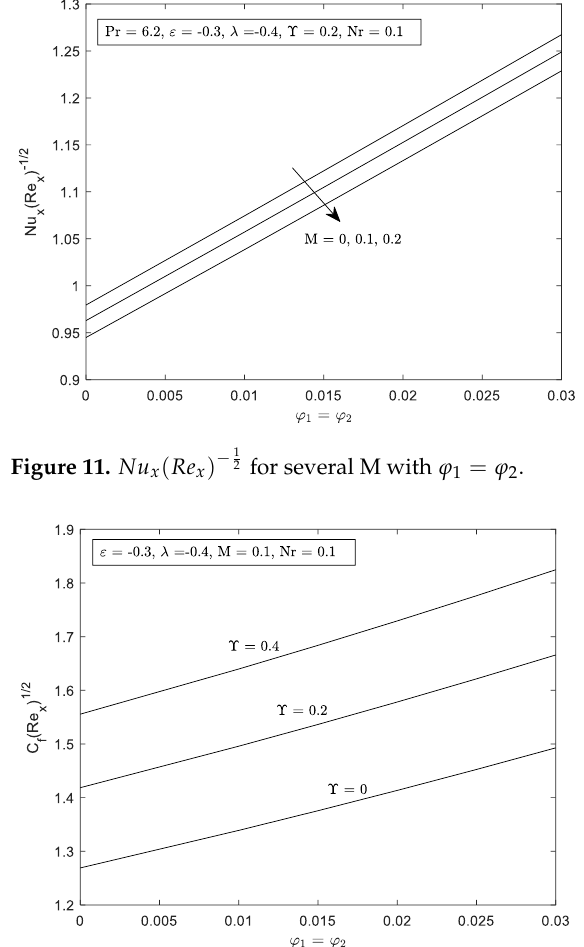
𝟏 1 𝟏 𝟏 2 for several Υ with ϕ 1 = ϕ 2 . 𝟐 for several ϒ with 𝜑 1 = 𝜑 2 . 𝟐 for several ϒ with 𝜑 1 = 𝜑 2 . 𝟐 for several ϒ with 𝜑 1 = 𝜑 2 .